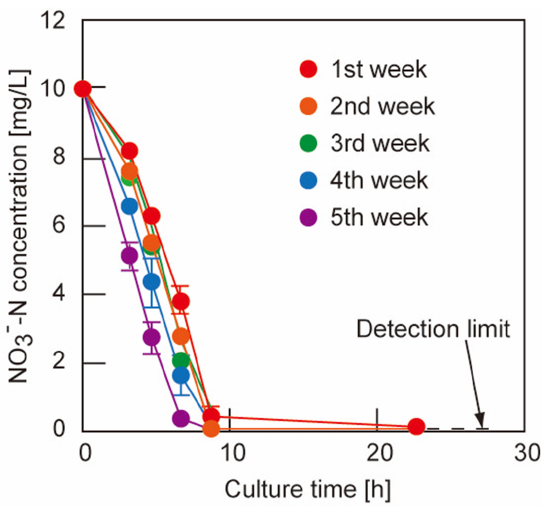
Figure 5. Repeated denitrification properties of alginate hydrogel beads with R. gra